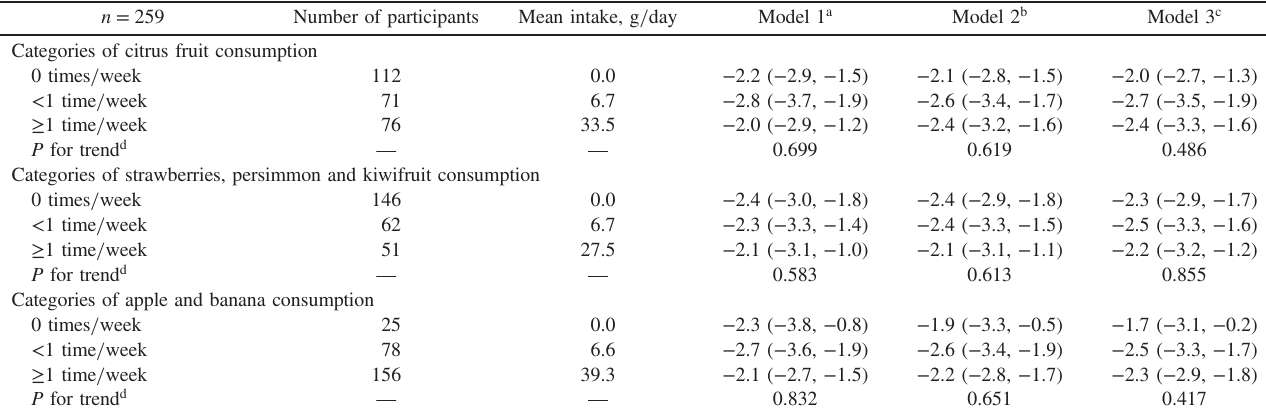
Table 3. Multivariable-adjusted relationships of consumption of di ff erent types of fruits with change in handgrip strength during the 3-year follow-up